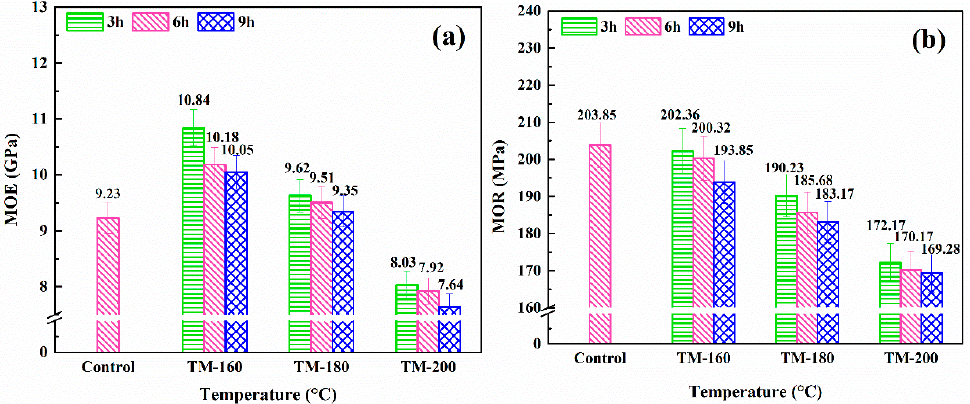
Figure 7. Effect of thermal modification on MOE ( a ) and MOR ( b ). Figure 7. E ff ect of thermal modification on MOE ( a ) and MOR ( b